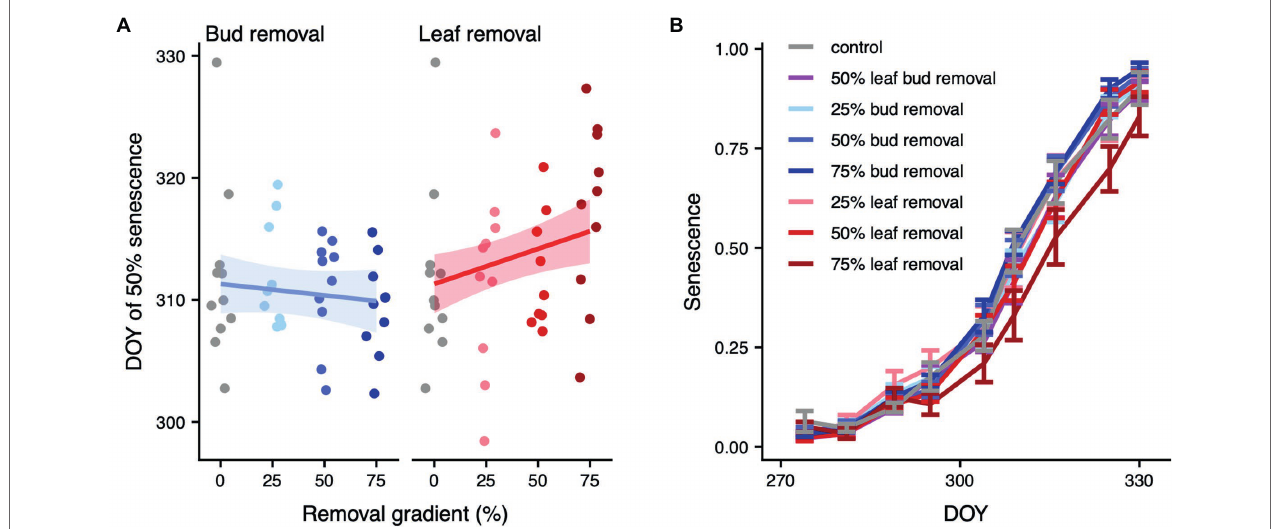
FIGURE 3 | Whole-plant leaf senescence. (A) DOY of 50% senescence across the bud (left panel) or leaf removal gradient (right panel). For each organ removal, we only display the treatments that have 0% of the other organ removed (i.e., the leaf removal panel does only include treatments where bud removal = 0). We added predicted means and approximate 95% confidence intervals for the model of DOY of 50% senescence. Model results are listed in Supplementary Table 5 . Model diagnostics are in Supplementary Figure 6 . (B) Whole-plant leaf senescence over time. Error bars mark the area of ±1 standard error around the mean. A graph of the whole time series of inverted relative SPAD index values is illustrated in Supplementary Figure 1 . Model results are listed in Supplementary Table 6 . Model diagnostics are displayed in Supplementary Figure 7